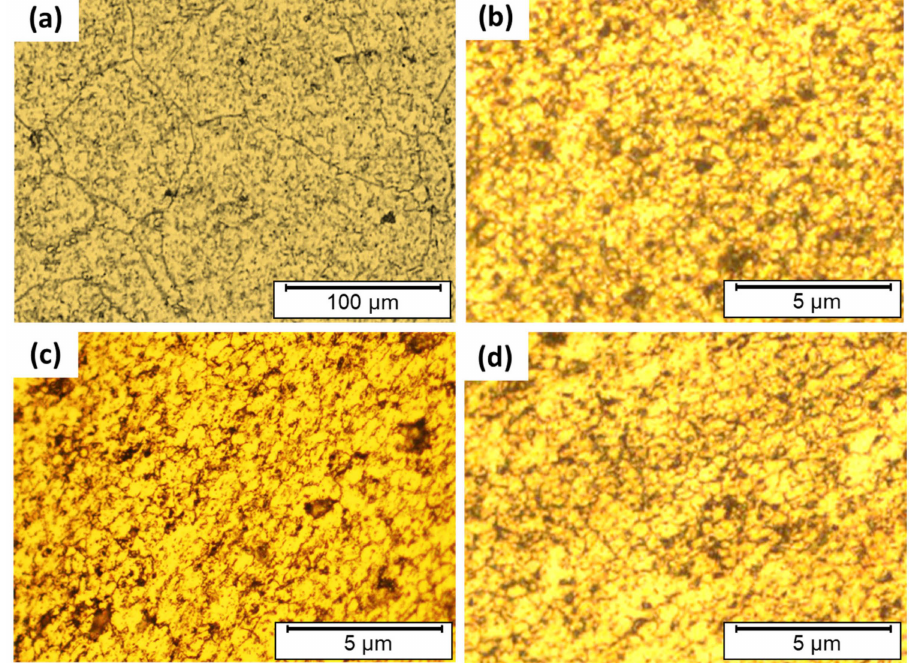
Figure 7. Optical microstructures of the as-received AA2011-O ( a ) and AMPs produced from AA2011- O at a rotation rate of 200 rpm and different feeding speeds of ( b ) 1 mm/min, ( c ) 2 mm/min, and ( d ) 3